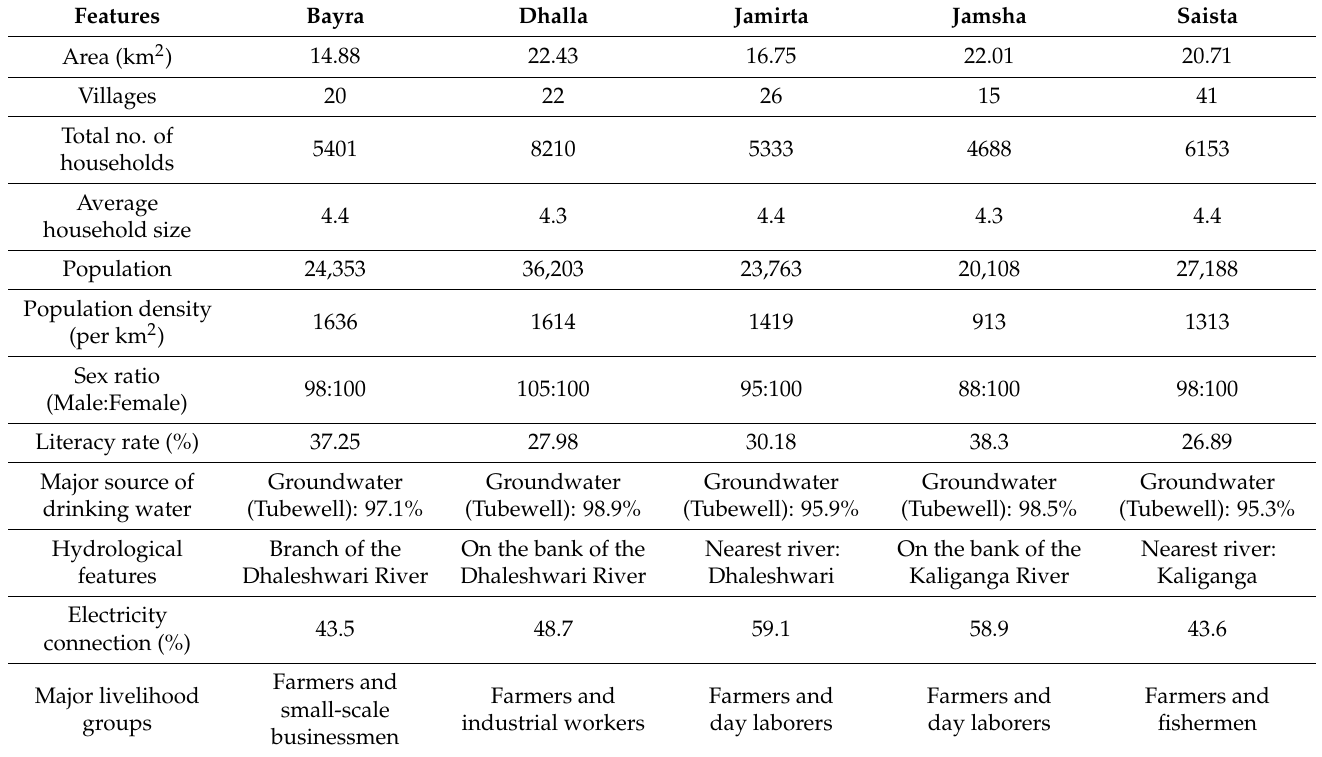
Table 2. Comparison of basic features among the five study